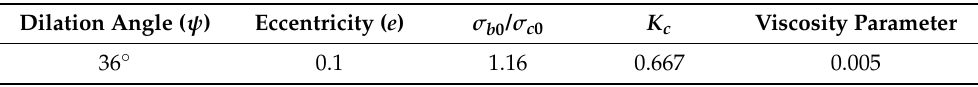
Table 2. Plasticity parameters of C50